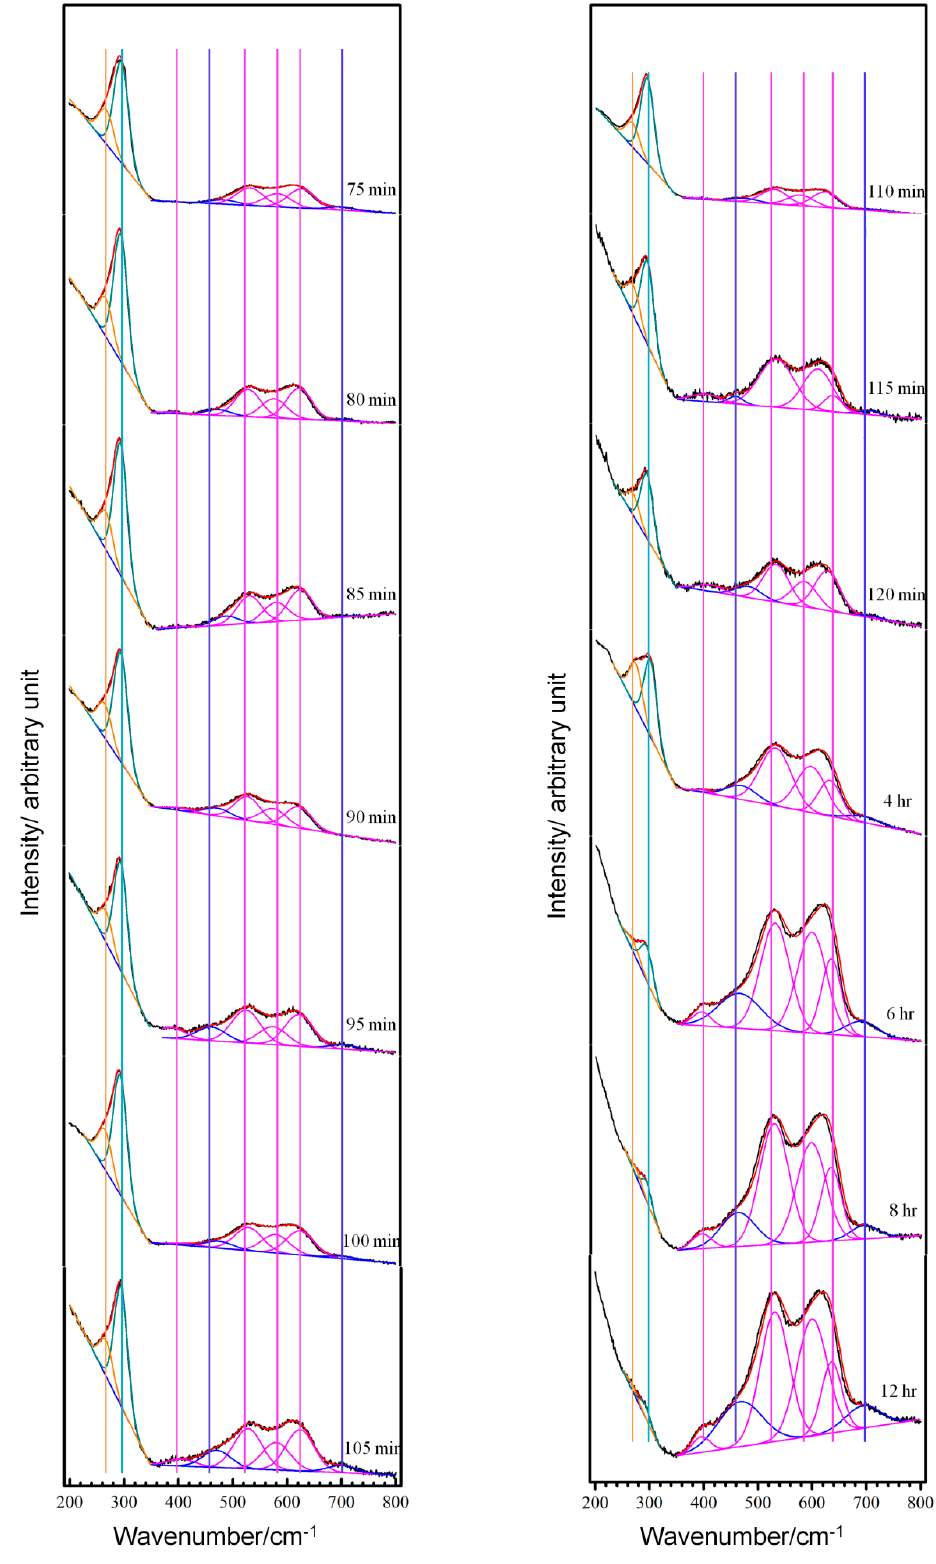
Figure 4. In-situ Raman spectra and fitted Gaussian components from copper electrode surface in neutral 3.5% (wt.) NaCl solution at OCP with immersion times varying from 0 to 12